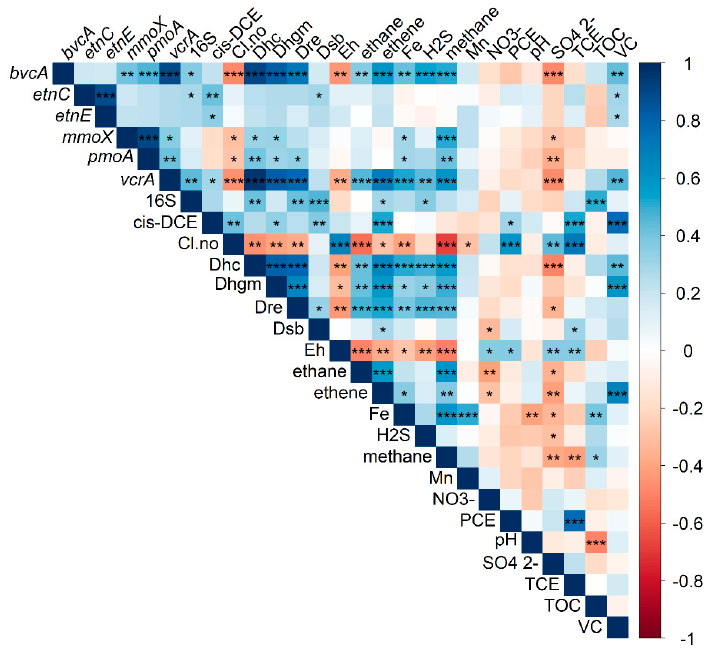
Figure 3. Results of Spearman correlation analysis (intensities of blue and red colours indicate values of positive and negative correlation coefficients, respectively; p ‐ values: *** = 0.001, ** = 0.01, * = 0.05). None of the chlorinated ethenes were correlated with the methanotroph functional genes mmoX and pmoA